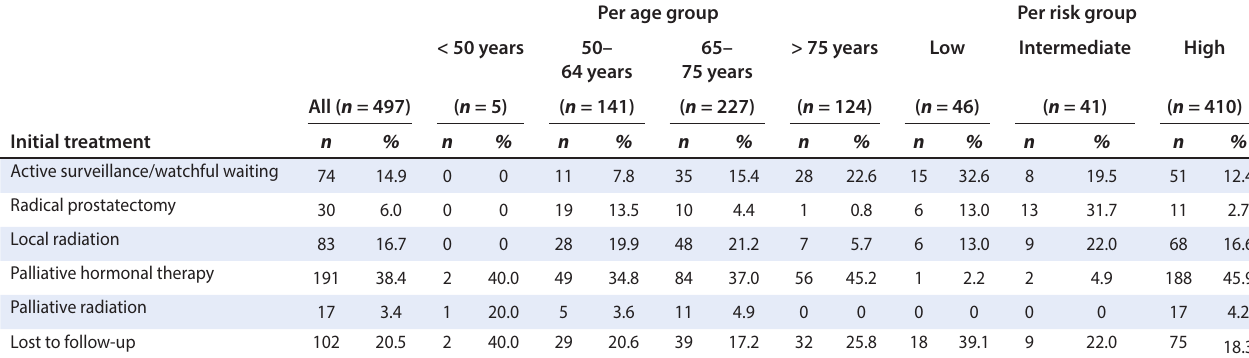
Table 5: Initial prostate cancer treatment per age group and per risk